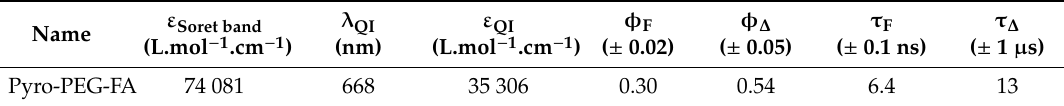
Table 1. List of the Photophysical properties of the PS in ethanol.